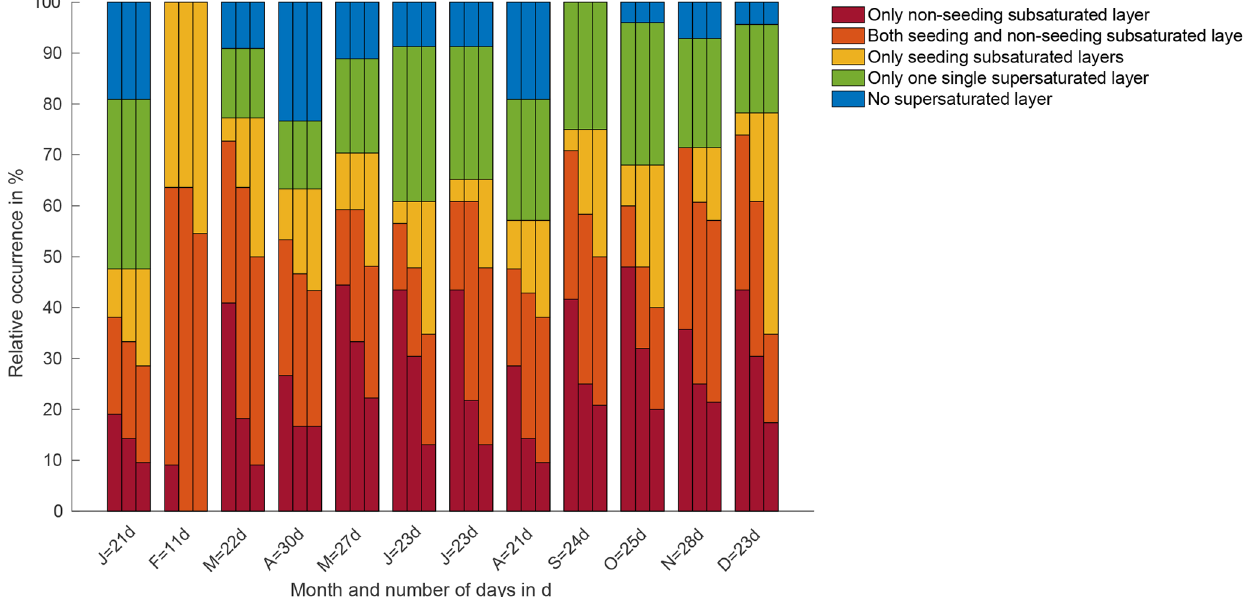
Figure 6. Temporal distribution of MLC days using classification step 1. For each month the left bar refers to the initial ice crystal size r = 100µm, the middle bar refers to the initial ice crystal size r = 200µm and the right bar refers to the initial ice crystal size r = 400µm. On the x axis the given number in the labels refers to the number of days (d) considered for the specific